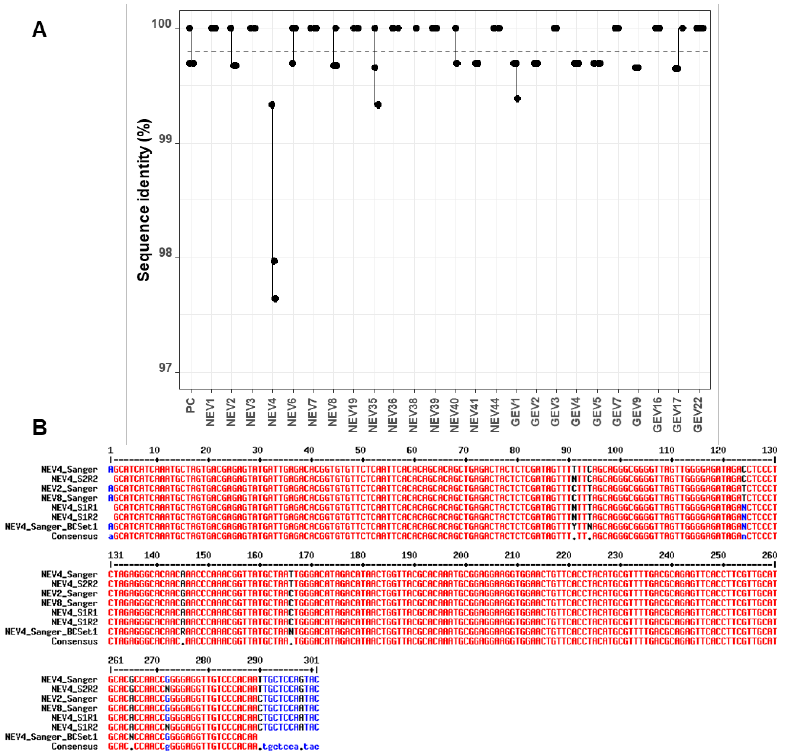
Figure 3. Variability in sequence identity across runs and barcode sets. ( A ) Variability in sequence identity per sample is shown for the consensus sequences of all replicates sequenced during the two Flongle runs. A small amount of horizontal noise was added to the x coordinates to visualize all points. The sequence identity was calculated in reference to the corresponding Sanger sequences. The dashed line indicates the mean sequence identity at 99.80% (SD = 0.37%). ( B ) Alignment of the outlier NEV4 consensus sequences and corresponding Sanger sequences. Additionally, NEV2 and NEV8, which matched the same genotype, were added to the sequence alignment, which was done using MultAlin [25]. Sample IDs are abbreviated as follows: S1 = Barcode Set 1, S2 = Barcode Set 2, R1 = Sequencing run 1, R2 = Sequencing run 2. BCSet1 refers to the Sanger sequence of the barcoded amplicon, as opposed to Sanger sequence obtained before barcoding.